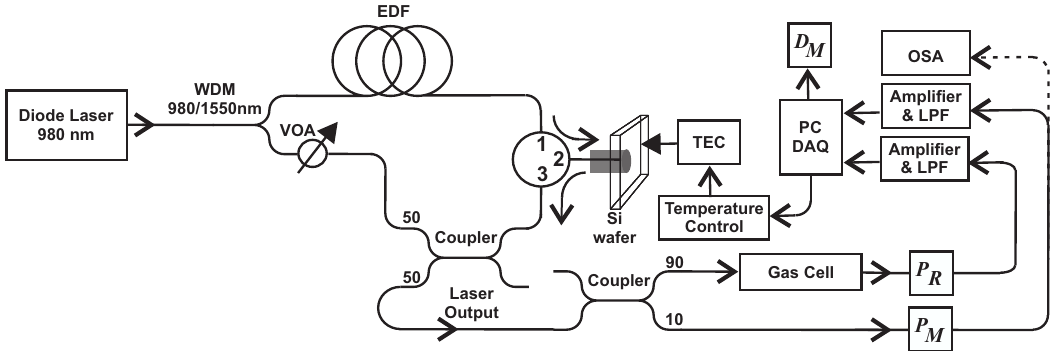
Figure 4. Hybrid C 2 H 2 sensor setup based on the LL-TLAS and NDS correlation spectroscopy